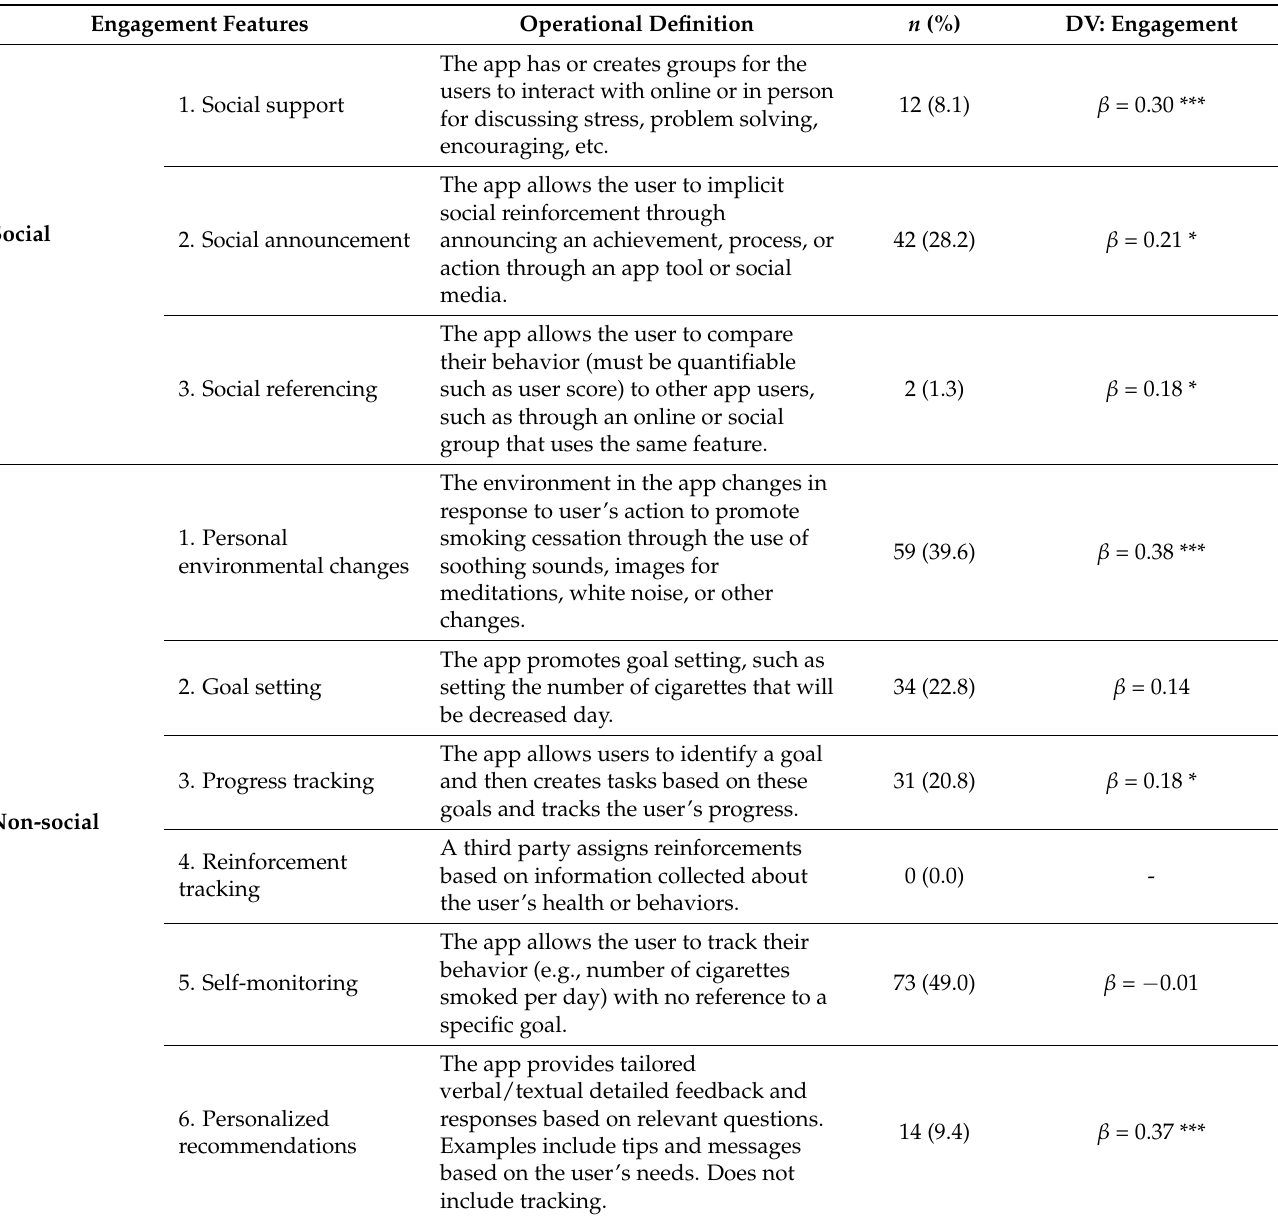
Table 1. Definition, frequency, and inferential statistics of engagement